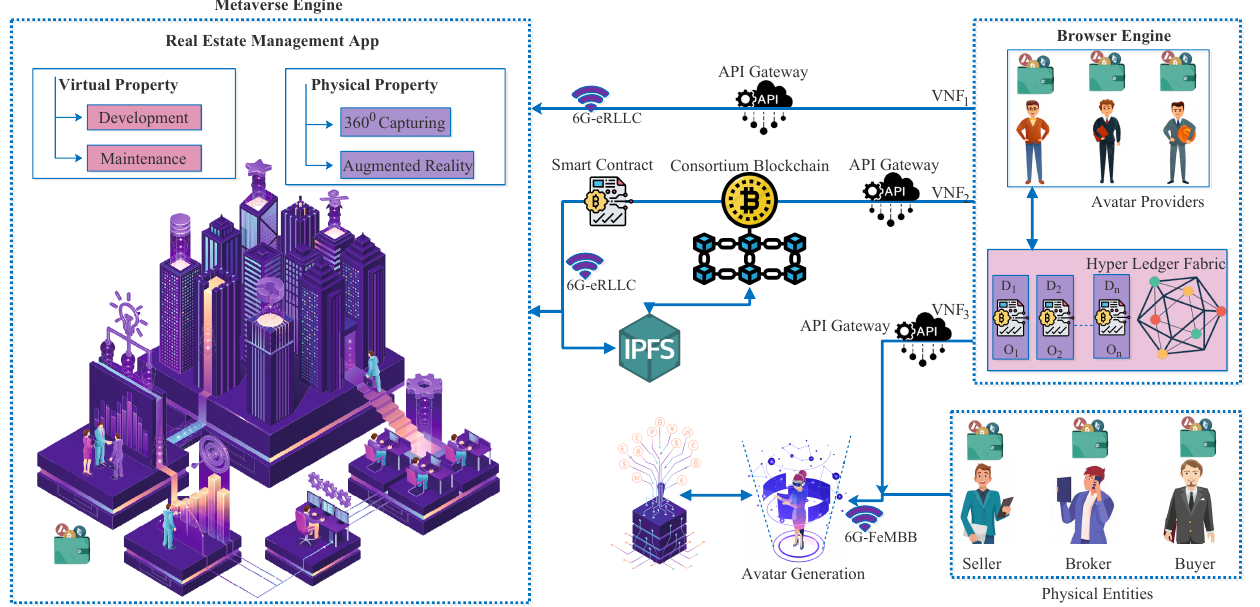
Figure 6. Case-study: a functional architecture of the Metaverse-assisted REM via the Web 3.0